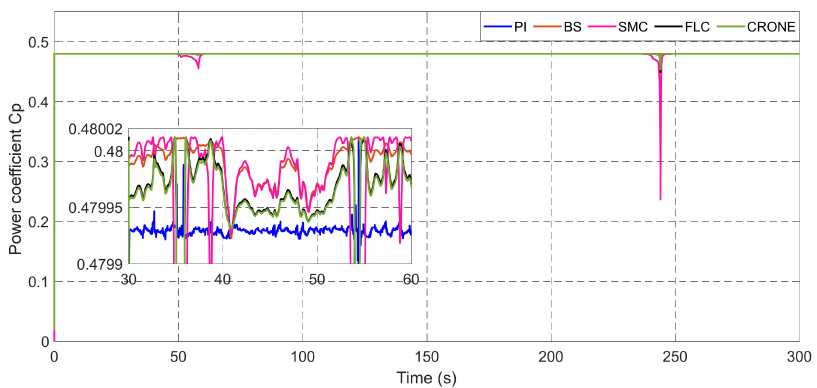
Figure 17. Power coefficient for PI, BS, SMC, FLC, and CRONE